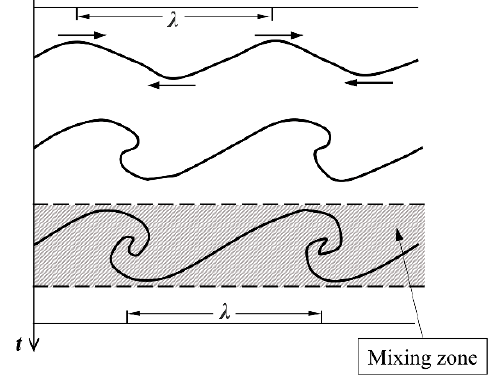
Figure 7. Schematic of the evolution of a K-H vortex at the interface.